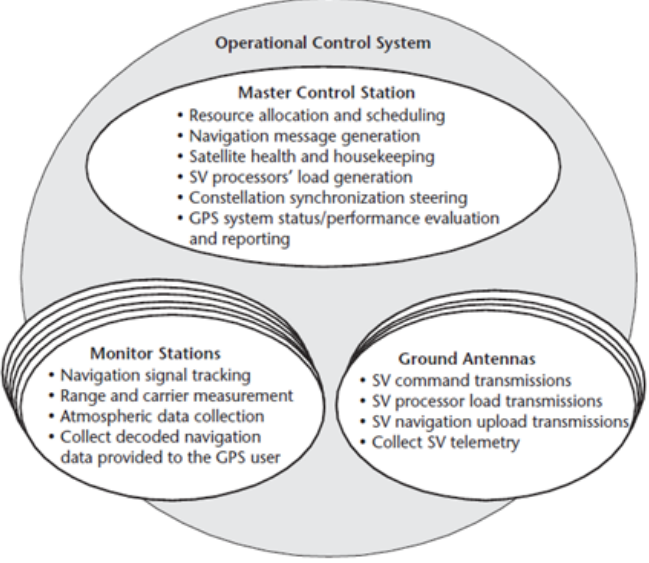
Figure 9. Control system overview. (Understanding GPS: principles and applications, Elliott Kaplan, Christopher Hegarty—2nd ed.,